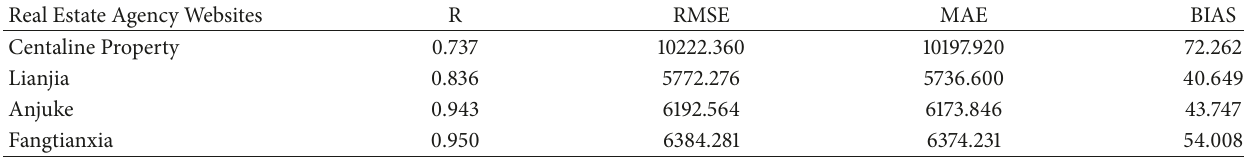
Table 4: Validation indices for city-level second-hand housing price